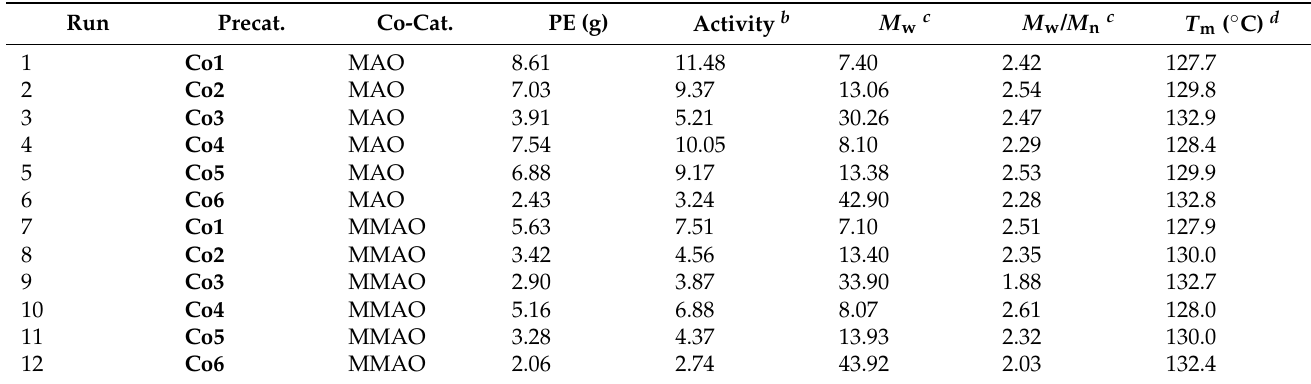
Table 4. Screening of Co1 – Co6 with either MAO or MMAO under optimized conditions a . Run